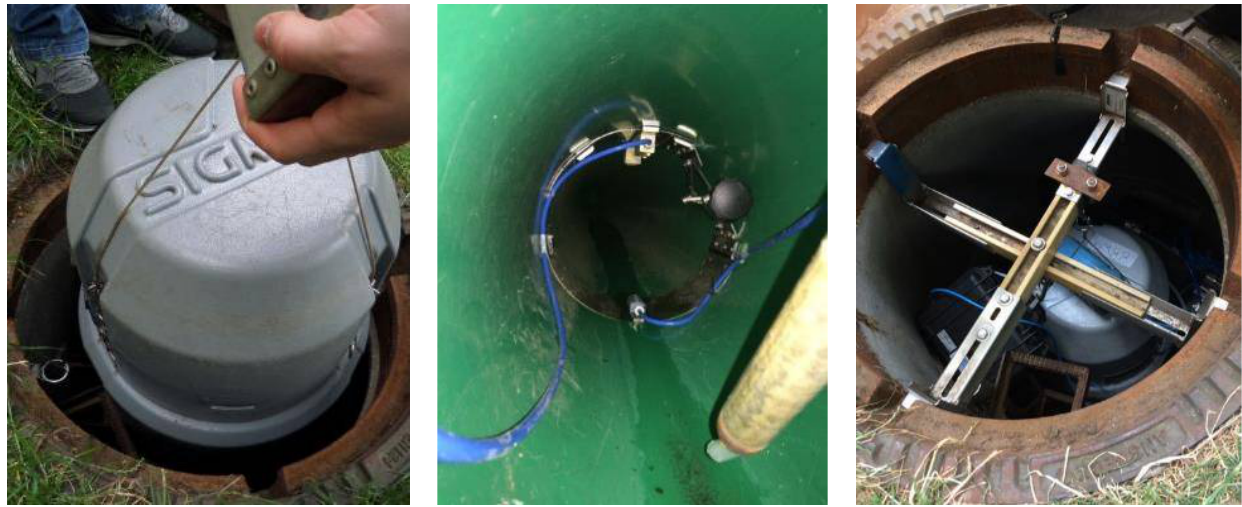
Figure A4. Installation of an automatic sampler and flow measuring device in a storm sewer and a manhole.